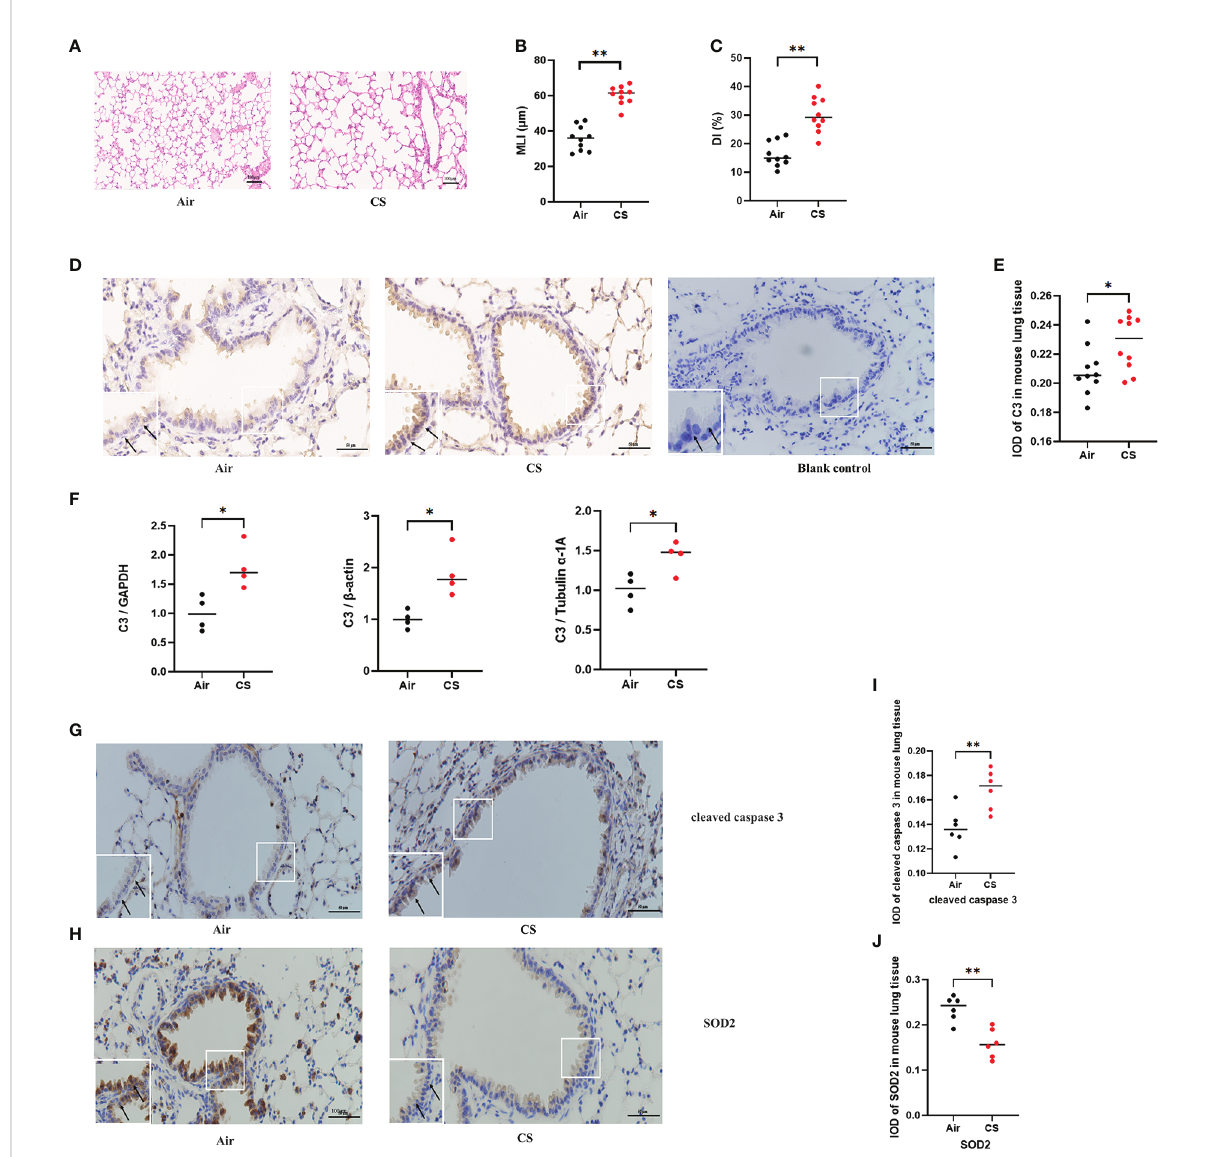
FIGURE 1 C3, cleaved caspase 3, and SOD2 expression was upregulated in AECs from mouse COPD. (A) H&E-stained lung sections. (B, C) Mean linear intercept (MLI) and destructive index (DI) was measured. (D) Representative immunohistochemical staining of C3 in AECs of the cigarette smoke-exposed group and air-exposed group. (E) The integrated optical density (IOD) in immunohistochemistry of C3. N = 10 per group. * P < 0.05. (F) C3 mRNA expression in total lung tissue of mice from air-exposed mice and cigarette smoke-exposed mice; N = 4. * P < 0.05. (G, H) Representative immunohistochemical staining of cleaved caspase 3 and SOD2 in AECs of air-exposed mice and cigarette smoke-exposed mice. (I, J) The IOD in immunohistochemistry of cleaved caspase 3 and SOD2. Data were expressed as group median values. N = 6 per group. ** P < 0.01. Original magni fi cation, ×400; scale bars: 50 mM for each fi